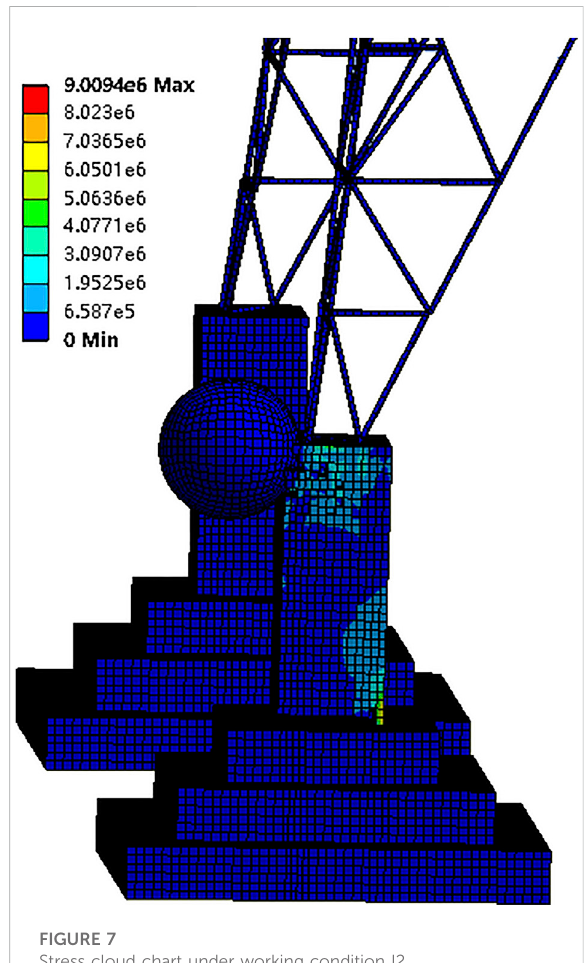
FIGURE 7 Stress cloud chart under working condition